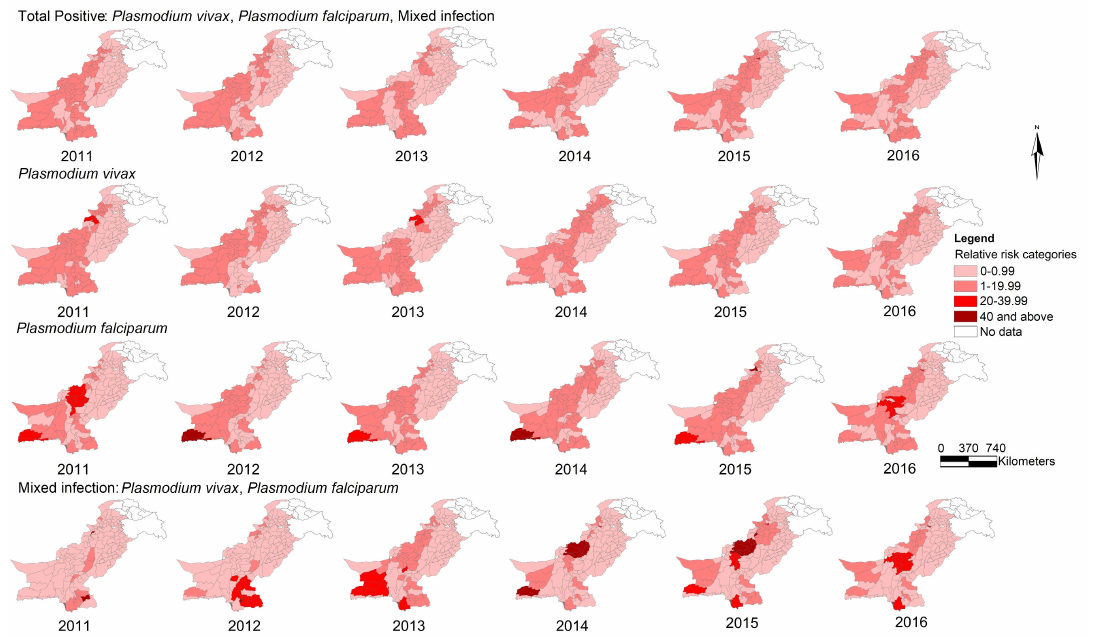
Figure 4. Relative risk of malaria by type at the district level in Pakistan,